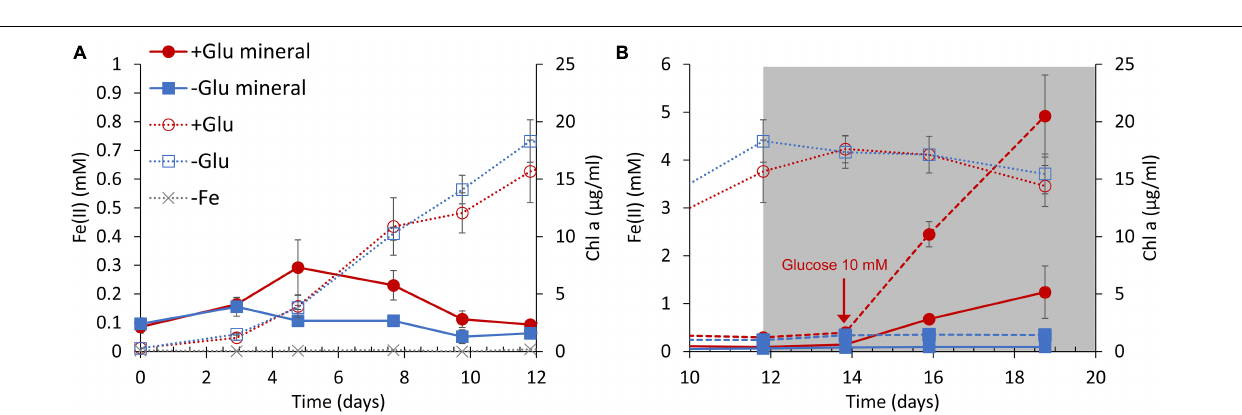
FIGURE 4 | S6803 and Fe(II) concentrations over time under anaerobic conditions with ferrihydrite as the sole iron source. The S6803 cells were inoculated to give an optical density at 730 nm of 0.1 and grown with N 2 bubbling. (A) The rapid growth phase under 100 µ mol m − 2 s − 1 light irradiation. (B) The stationary phase under dim light irradiation (gray background). The red and blue lines indicate data obtained with and without glucose, respectively. The solid and broken lines indicate the Fe(II) concentrations in cell suspension and solid iron samples (see also Supplementary Figure 8 ), respectively. The dotted lines indicate chlorophyll concentration and the gray dotted lines indicate chlorophyll concentration in cultures without ferrihydrite. Values are means ± one standard deviation (error bars) of three replicate